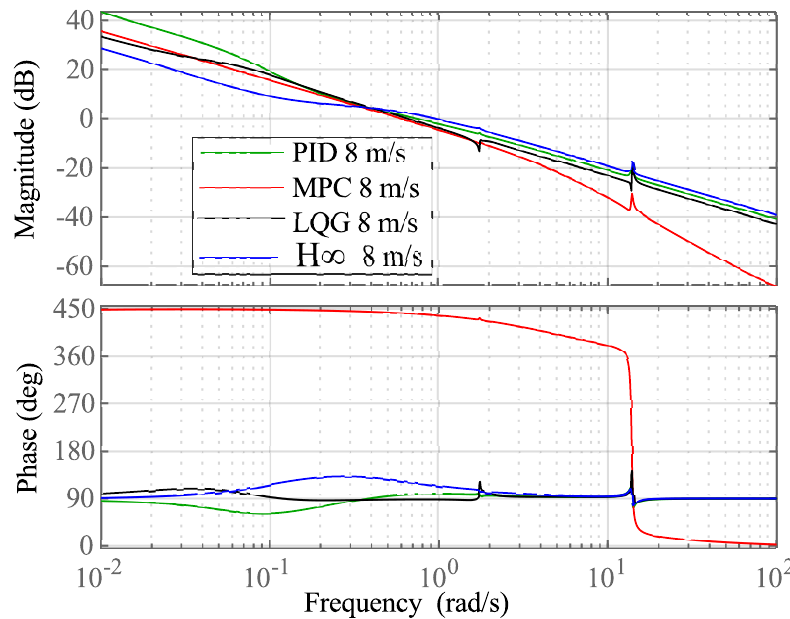
Figure 12. Open–loop frequency responses of PID, MPC, LQG, and H ∞ based on Bladed linearized model in mode 1.